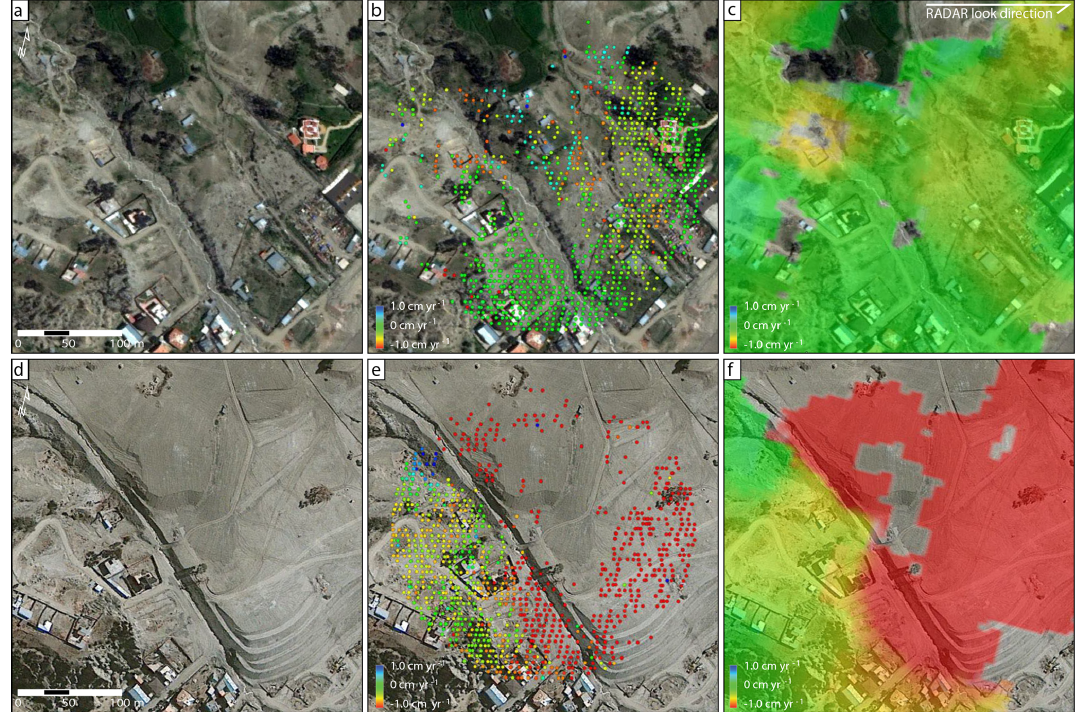
Figure 7. Typical density and spacing of HDS-InSAR results for an area of mixed suburban, agricultural, and commercial development. Both the pre-failure stack (a, b, c) and post-failure stack (d, e, f) are shown. Panels for each stack depict satellite images showing land cover without InSAR data (a, d) ; point data representing HDS neighbourhoods (pixel neighbourhoods) (b, e) , each recording a displacement time history; and linear displacement map interpolated from HDS points (c, f) . Localized variability in HDS results is suppressed by linear deformation interpolation. Displacement rates are in the satellite line of sight. The deforming area is the southern boundary of the active part of the landslide toe. Base image is a 4 January 2011 QuickBird image viewed in GoogleEarth ™ . Base images are from GoogleEarth ( a, b, c 4 January 2011 and d, e, f 25 July 2011). See Fig. 8a, c for